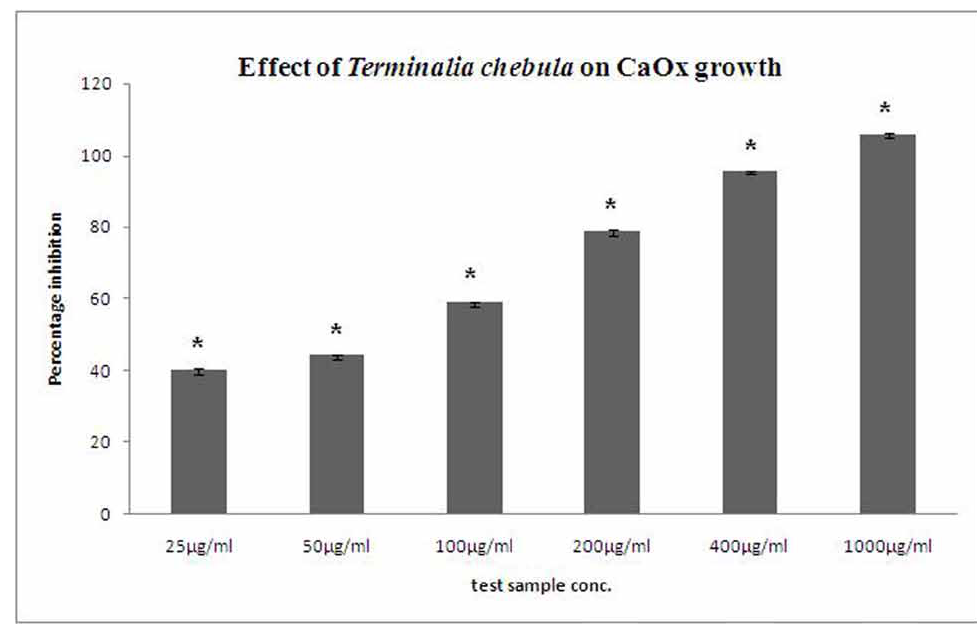
Figure 2 - Effect of crude extract of Terminalia chebula on growth of CaOx. Data are mean ±